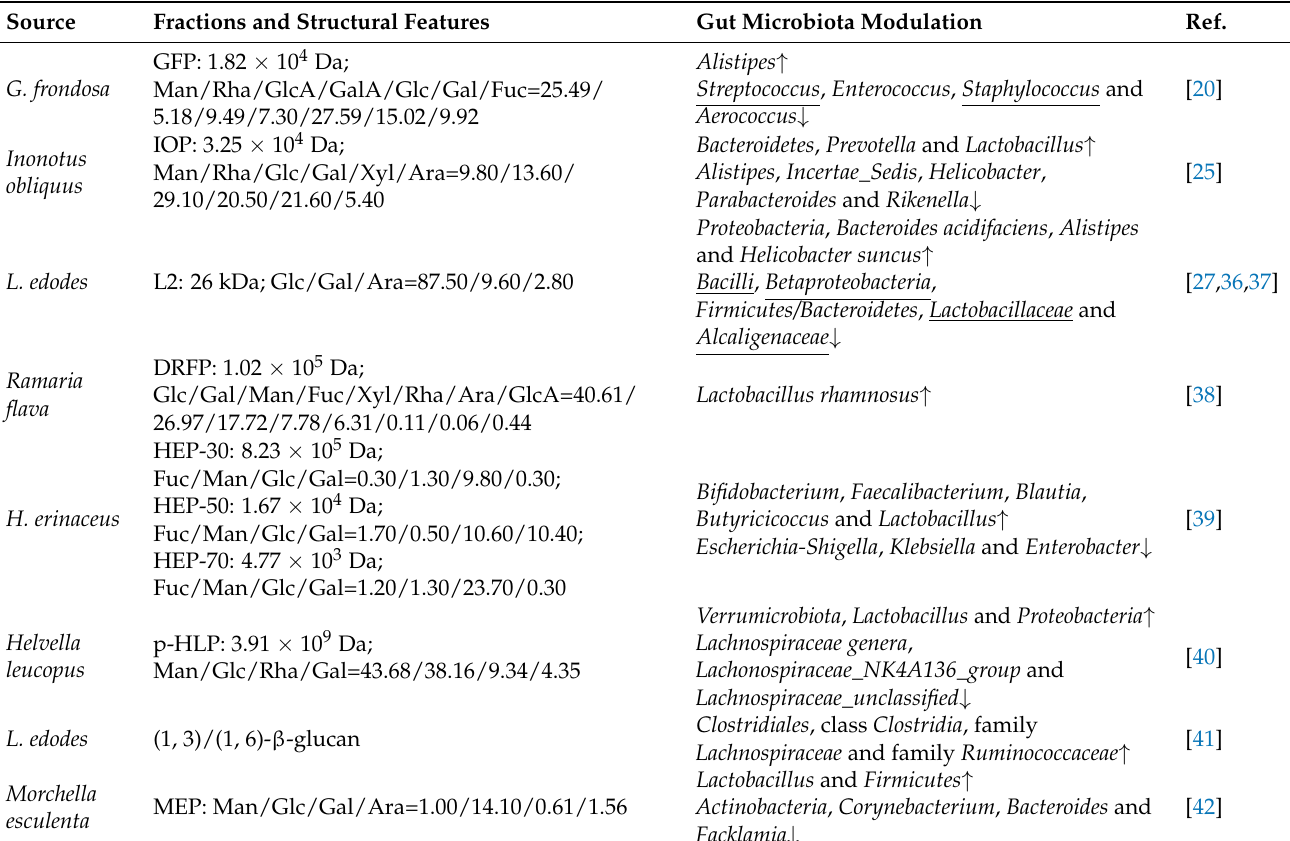
Figure 1. The typical structure of mushroom polysaccharides. ( A ) The structure of Grifola frondosa [31]. ( B ) The structure of Hericium erinaceus [32]. ( C ) The structure of G. lucidum [33]. ( D ) The structure of Pleurotus eryngii [34]. ( E ) The structure of Lentinula edodes [35]. Table 1. Effects of the source and structural features of mushroom polysaccharide on the regulation of gut microbiota.